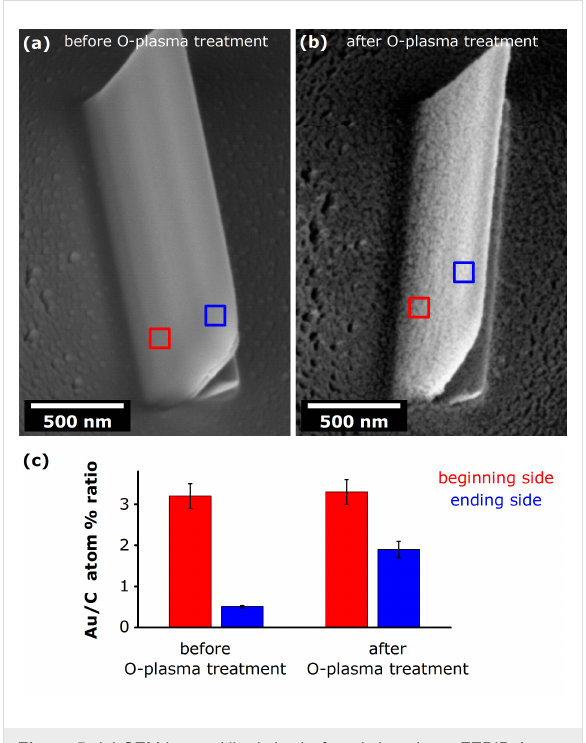
Figure 5: (a) SEM image (tilted view) of a pristine planar FEBID Au nanostructure of a large compositional gradient (see Figure 3d) before O-plasma treatment. (b) SEM image (tilted view) of the same structure after O-plasma treatment. (c) Elemental composition of the “beginning” and “end” of the planar nanostructure, acquired before and after O-plasma treatment. The EDX measurements were performed on 100 × 100 nm 2 areas for 60 s. For detailed EDX data see Table S4 in Supporting Information File